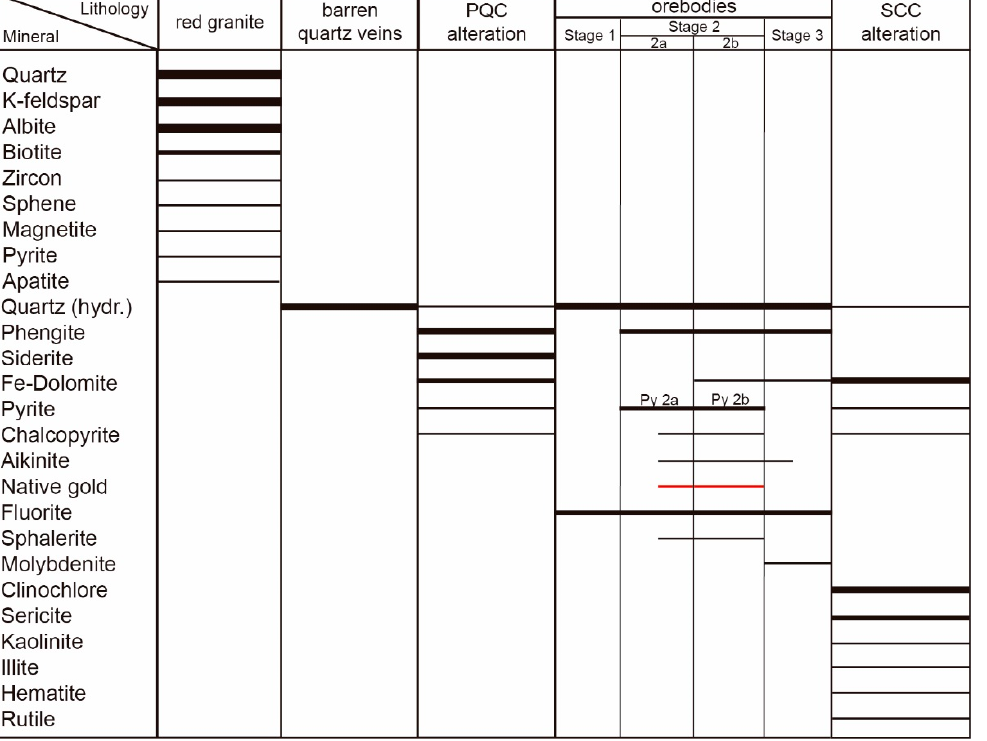
Figure 7. Paragenetic sequence of the red granite, barren quartz veins, mineralized veins, and hydrothermal alteration at the Passa Três gold deposit. The width of the solid lines denotes the relative abundance of minerals. The late argillic alteration in the deposit is not indicated. Criteria for differentiation between phengite and sericite is based on grain size.